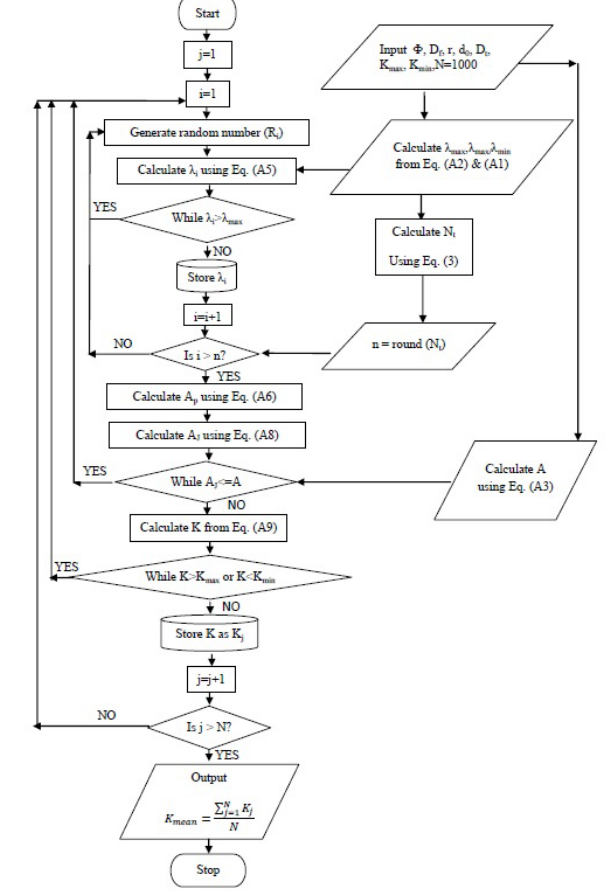
Fig. 2. Flow chart to apply the Monte Carlo simulation technique for permeability estimation.